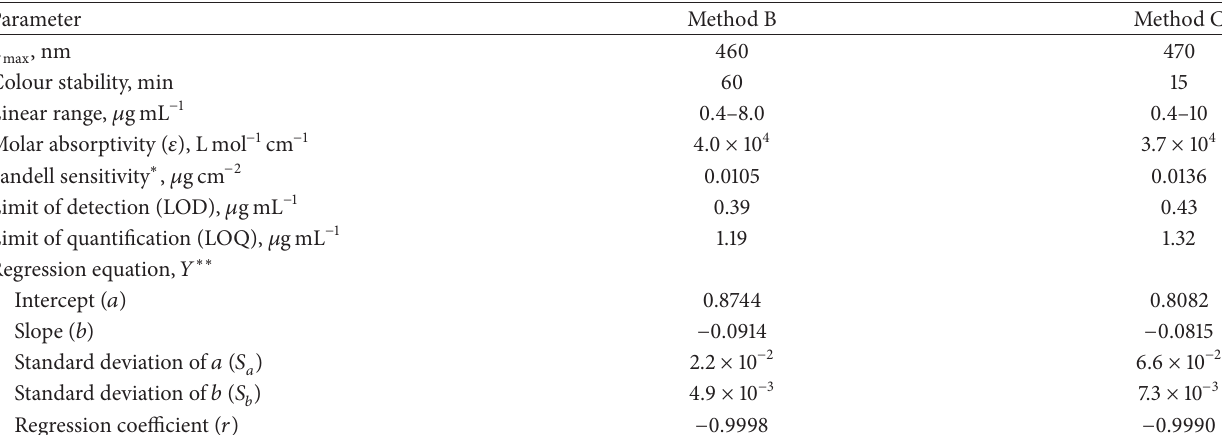
Table 2: Sensitivity and regression parameters.